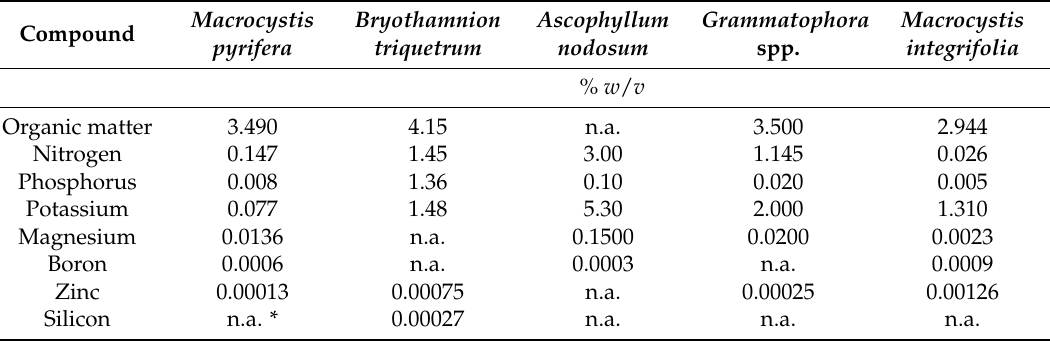
Table 1. Chemical composition of seaweed extracts evaluated in cucumber production.